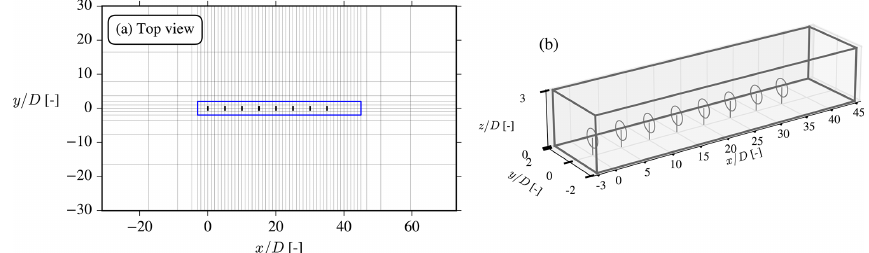
Figure 20. A x – y cut of the domain with every eighth cell shown (a) and a 3D view of the wake domain (b) for the aligned-row case. The size of the domain is L x /D = 104, L y /D = 60, and L z /D = 25. A rough-wall BC and an inlet BC are used for the lower and upper BCs, respectively.